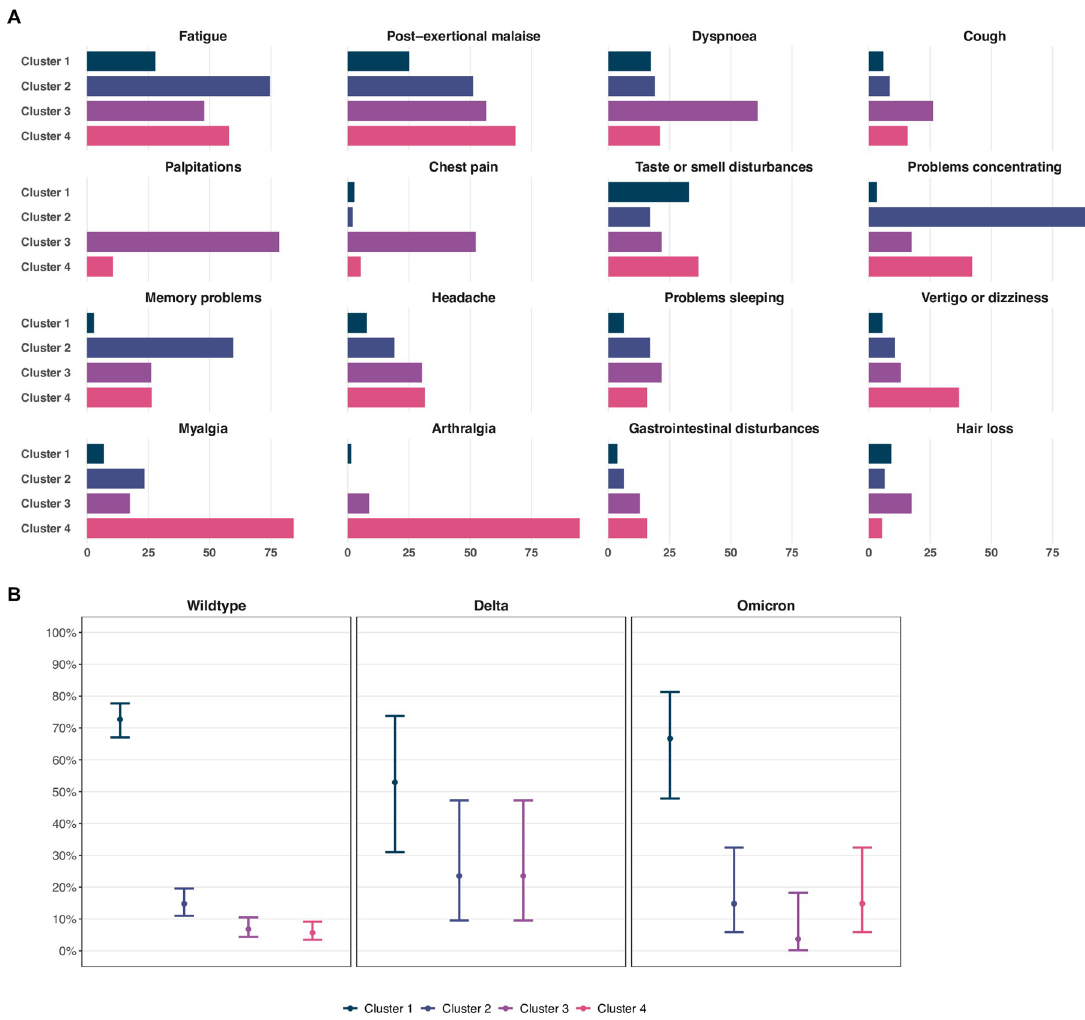
Fig 3. Prevalence of specific post COVID-19 condition-related symptoms six months after SARS-CoV-2 infection across symptom clusters. Four clusters of individuals with post COVID-19 condition at six months after infection were identified based on multiple correspondence and hierarchical cluster analyses, consisting of individuals with (1) diverse systemic symptoms and lower symptom count, and with (2) predominantly neurocognitive, (3) cardiorespiratory, or (4) musculoskeletal symptoms. Panel A depicts distributions of specific post COVID-19 condition-related symptoms across clusters. Panel B shows the proportion of individuals belonging to each cluster across infections with Wildtype, Delta, and Omicron SARS-CoV-2. Points represent point estimate and error bars represent 95% Wilson confidence intervals for estimated